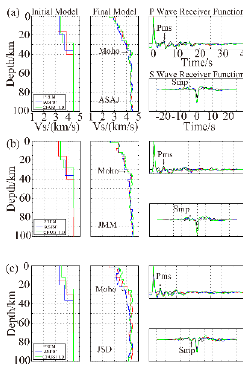
Figure 2: Examples of the P- and S- wave receiver functions joint inversion results in Japan. (a) Station ASAJ; (b) Station JMM; (c) Station JSD (Stations location shown in Figure 1). In each subgraph, the left panel represents Initial